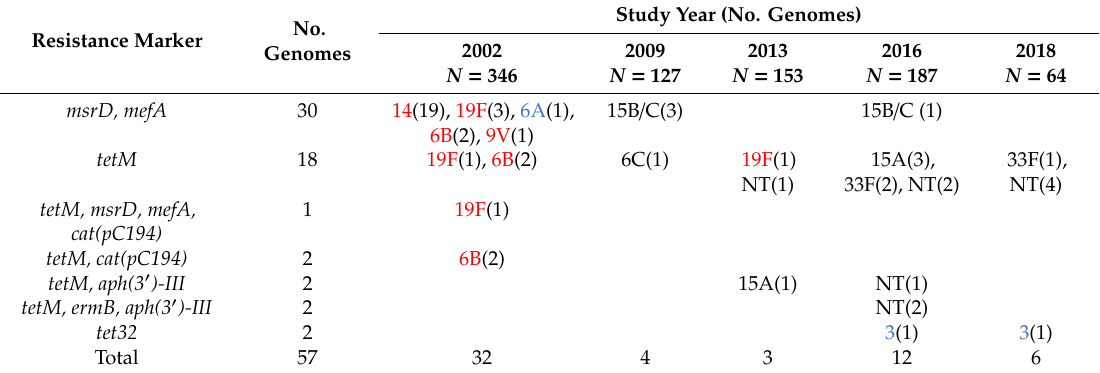
Table 5. Summary table showing results of Abricate resistance marker detection stratified by year and